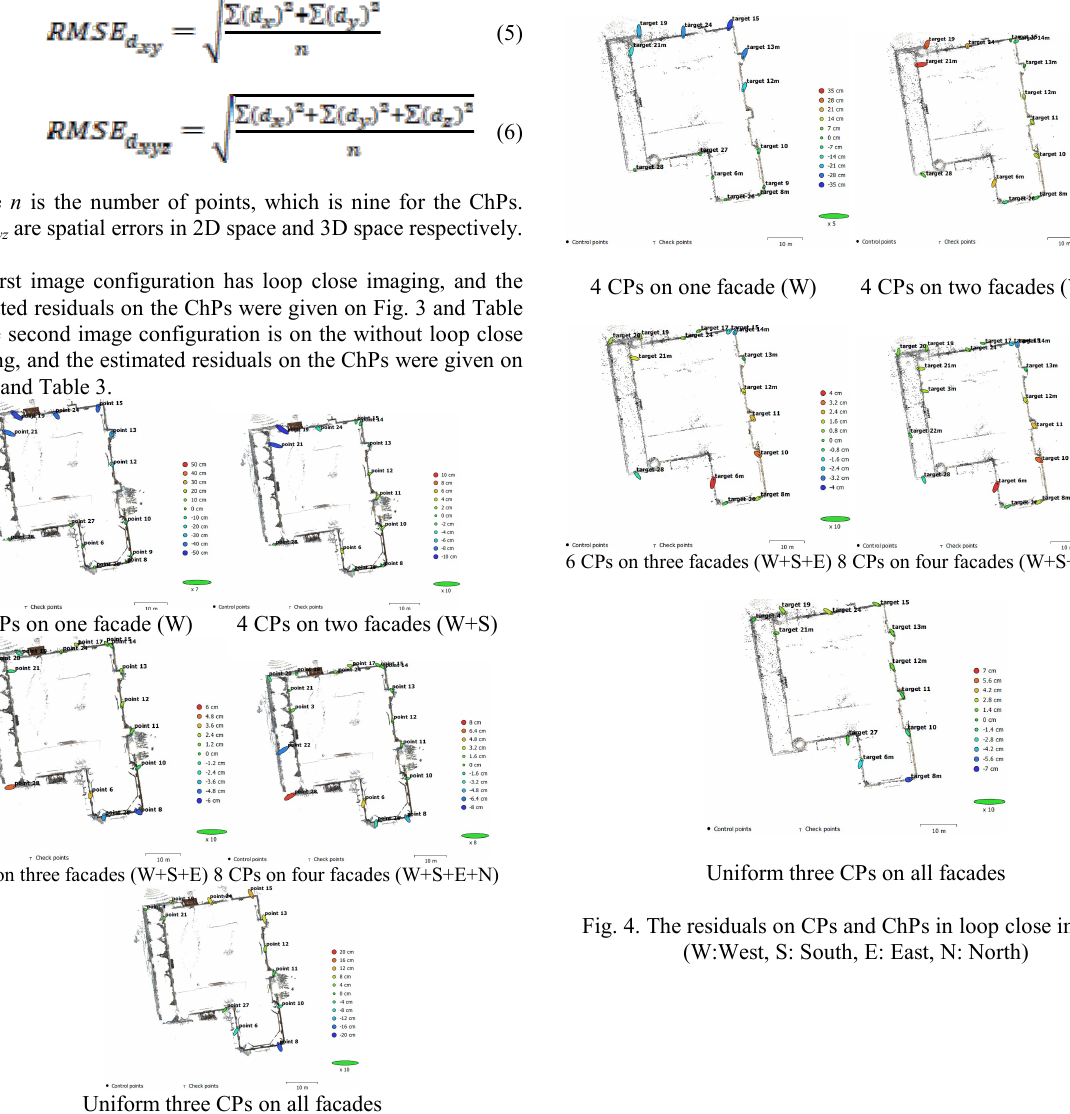
Fig. 3. The residuals on CPs and ChPs in wihout loop close imaging (W:West, S: South, E: East, N: North)